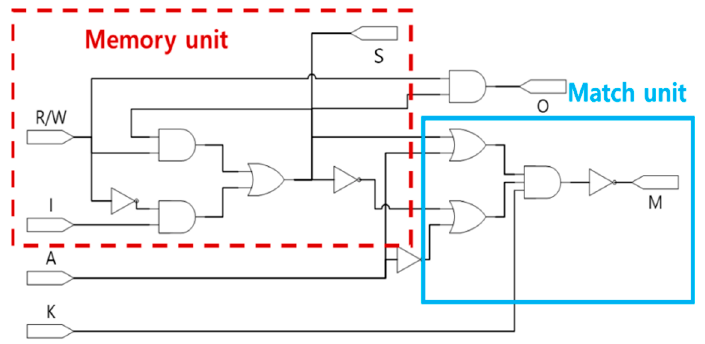
Figure 7. Logic diagram of CAM cell.